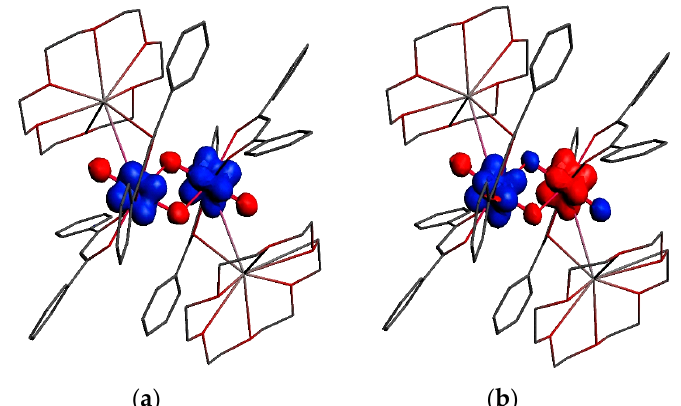
Figure 22. ZORA/B3LYP spin density distributions for the HS (triplet) and BS states of the dioxo [UO 2 (dbm) 2 K(18C6)] 2 system (blue color: positive and red color: negative spin density). The isodensity surface corresponds to a value of 0.0025 e bohr –3 . (Unpublished results). ( a ) (HS); ( b ) (BS).